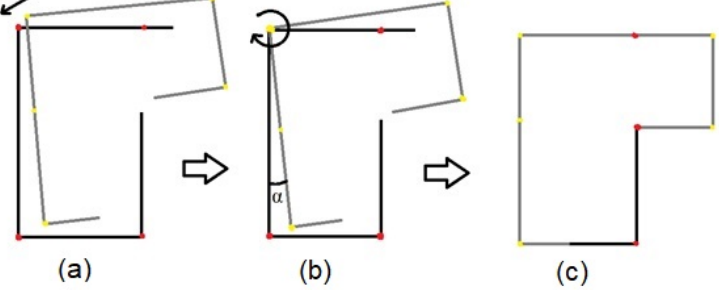
Figure 14. ( a ) Translation; ( b ) rotation; ( c ) registered point clouds. Intersection points of the previous point cloud ( black ) and the next point cloud ( grey ).